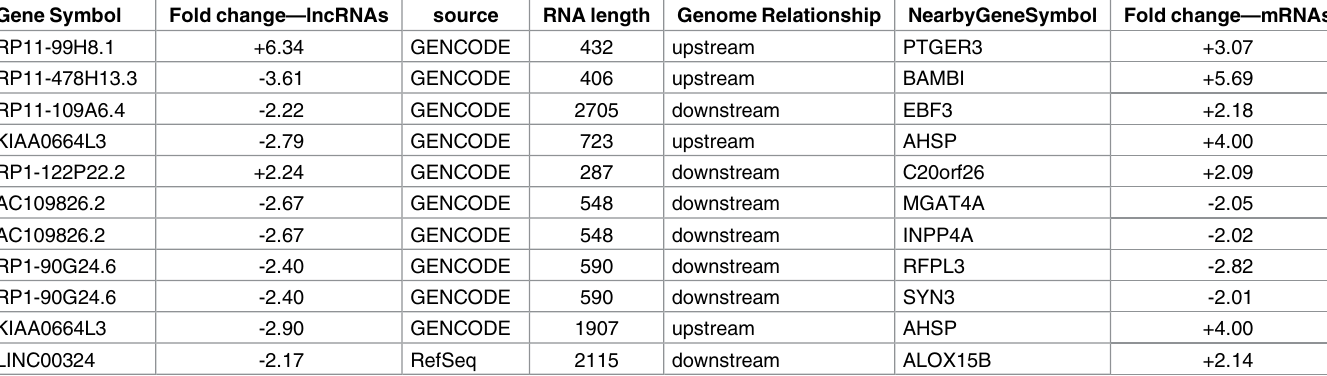
Table 3. Deregulated enhancer-like lncRNAs and nearby coding genes (distance < 300 kb). Gene Symbol